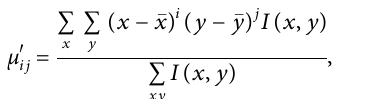
Frontiers in Computer Science |